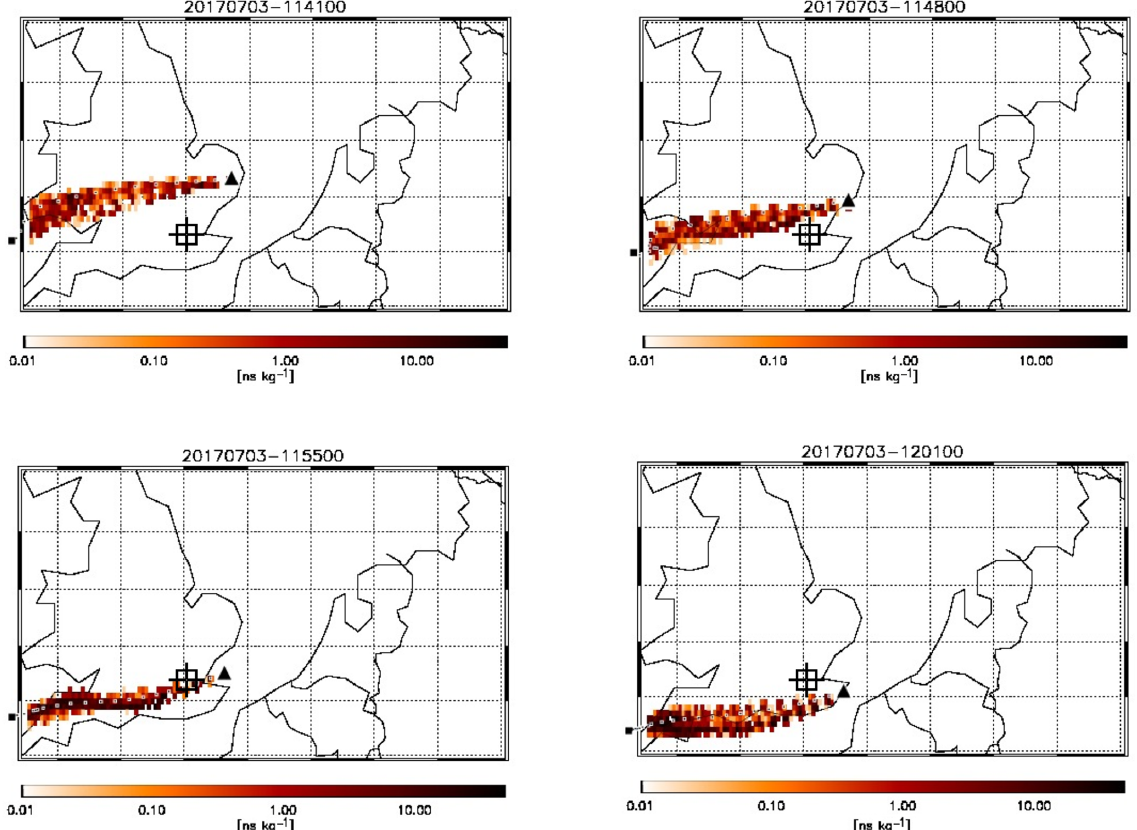
Figure 3. FLEXPART modelled footprint of air mass arriving at the location of FAAM BAe-146 (black triangles) at four different positions along the reciprocal runs of flight C016. Each coloured pixel indicates the relative contribution of an inert tracer in that air to the total concentration of that tracer sampled on board. The large black square shows the point of release of the air 24h prior to being intercepted by the aircraft. The dotted line of black and white squares shows the hourly weighted average trajectory of the air mass based on the relative contributions shown. The square target indicates the approximate position of central